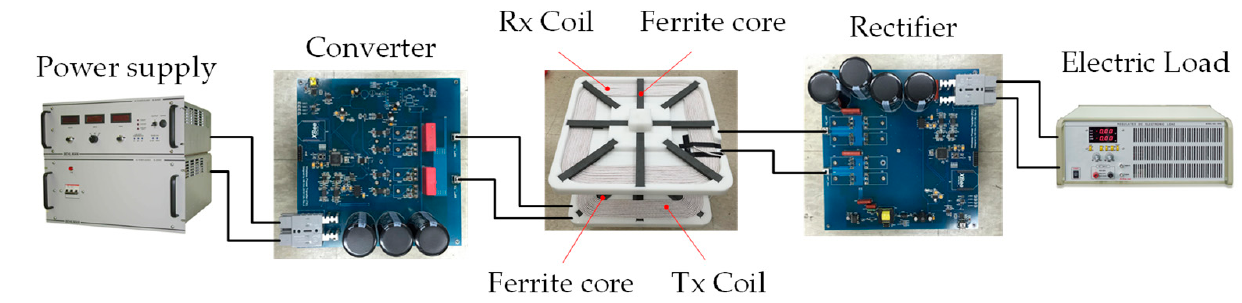
Figure 15. Configuration of the experimental system.